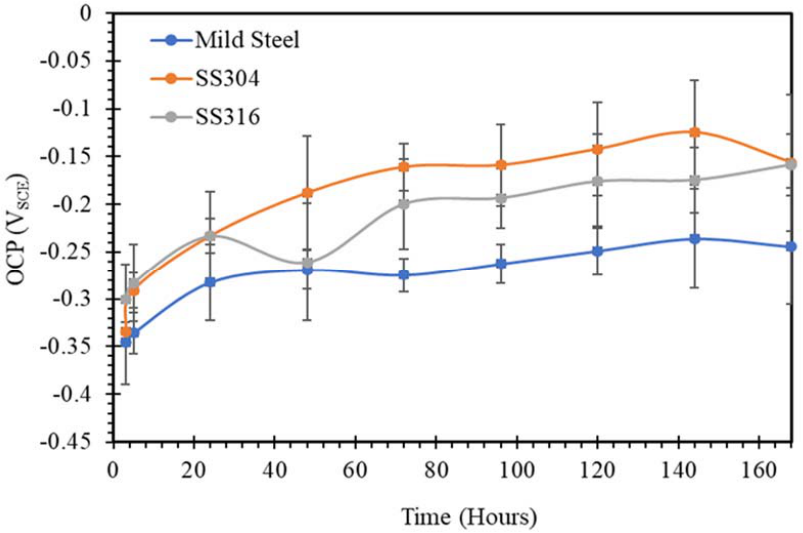
Figure 2. OCP vs. time plots of mild steel, SS304 and SS316 in NC solution.